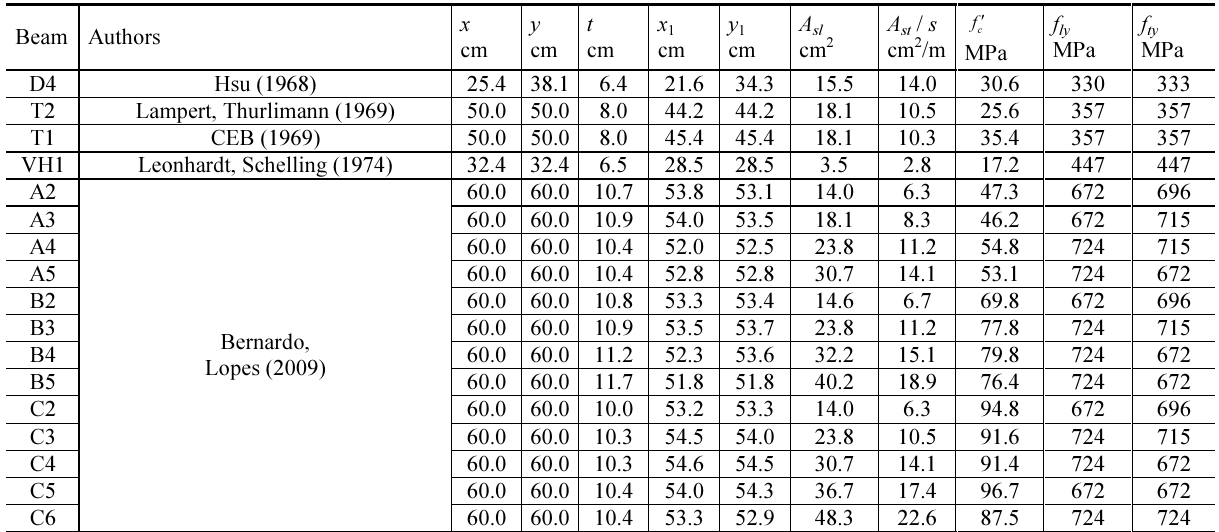
Table 6. Properties of experimental RC hollow